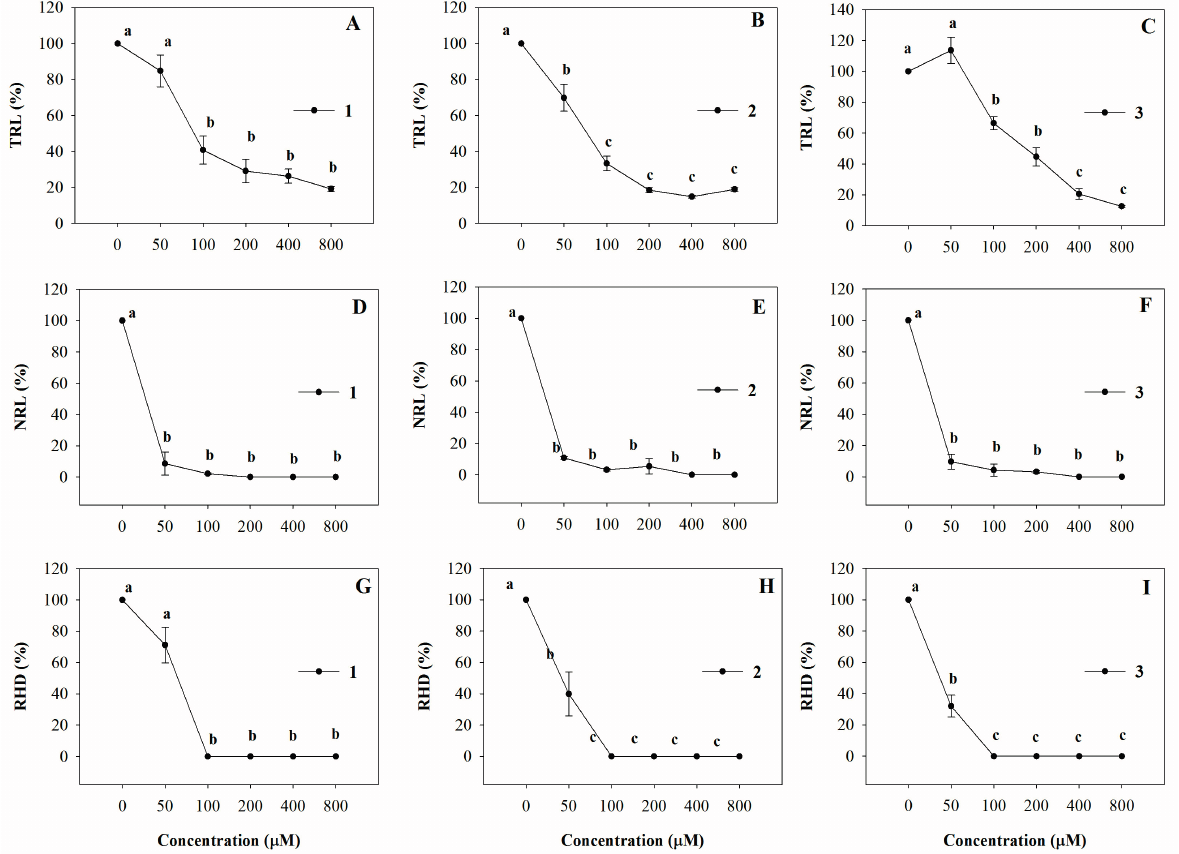
Figure 4. Dose-response curves of root morphology of A. thaliana seedlings treated with 1 – 3 for 15 days: ( A – C ) Total Root Length (TRL); ( D – F ) Lateral Root Number (NLR); ( G – I ) Root Hair Density (RHD). Data are expressed as percentage of the control. Different letters (a–c) along the curves indicate significant differences at p ≤ 0.05). Homoscedastic data were analyzed by ANOVA with Tukey’s test, whereas the heteroscedastic ones were analyzed with Tamhane’s T2. N =